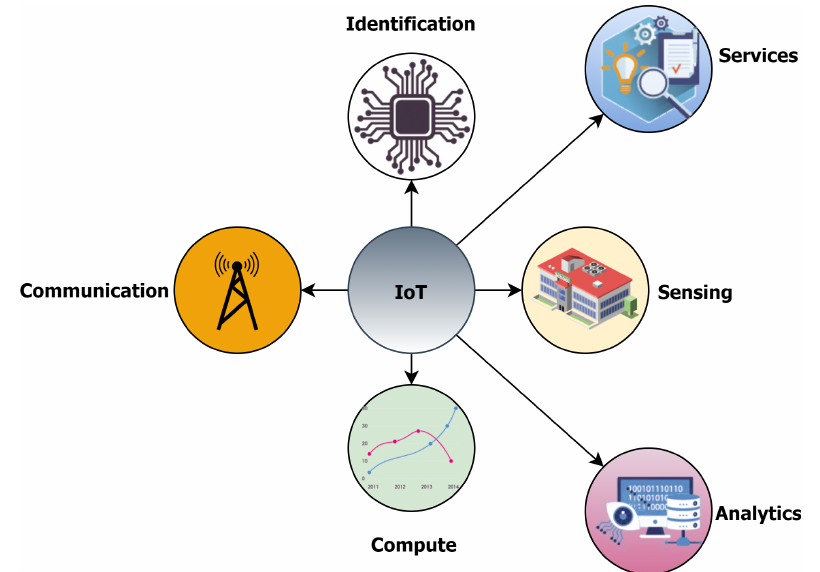
Figure 7. The IoT functional